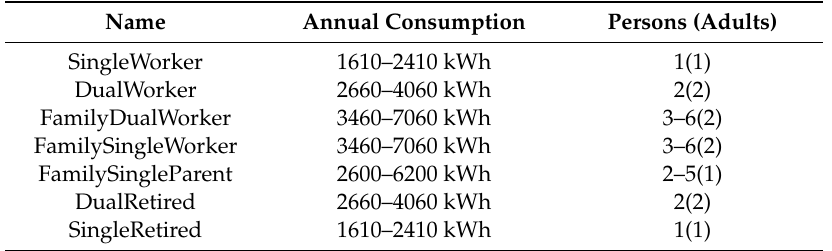
Table 4. Pre-defined households configurations in ALPG based